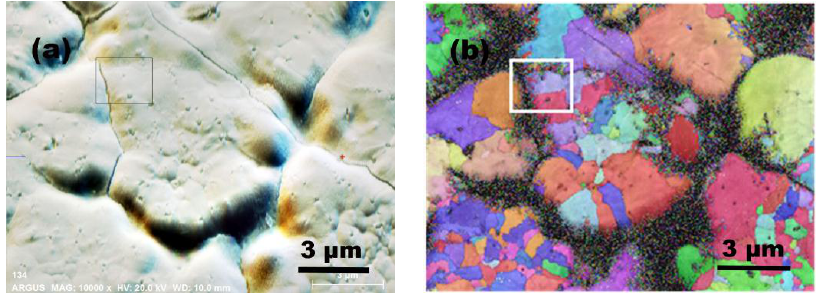
Figure 4. Cont . Figure 4.